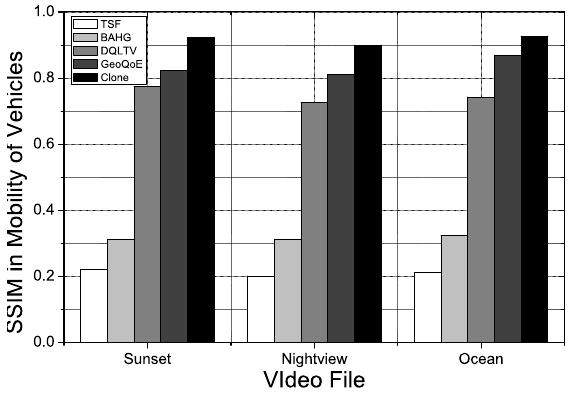
Figure 17. SSIM for each video file in a mobility